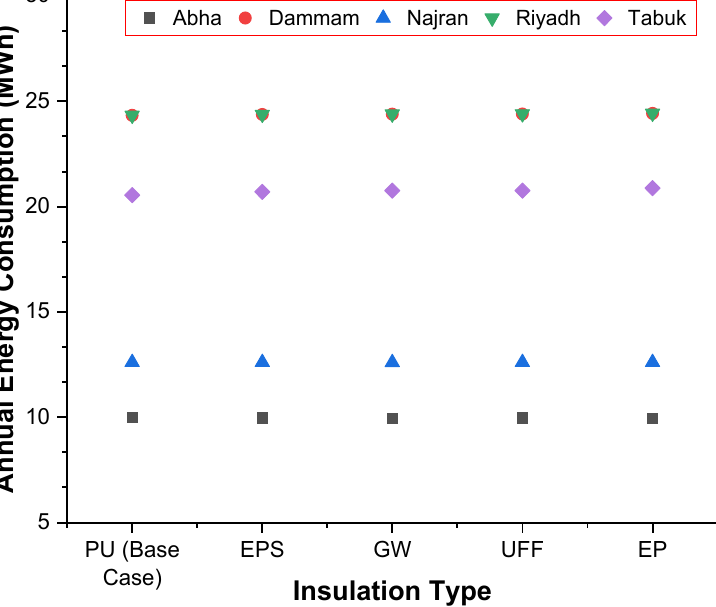
Figure 8. Annual energy demand by insulation type for different climates.